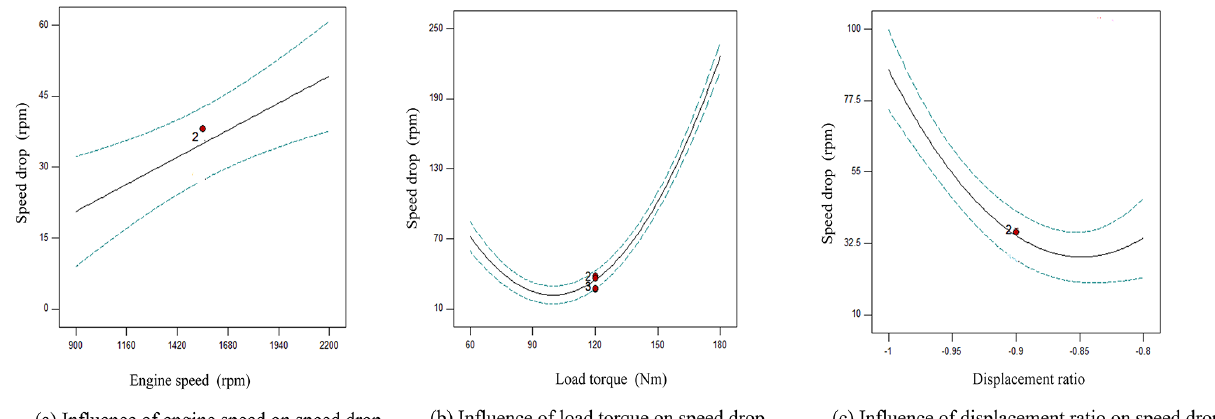
Figure 6. Single influencing factor analysis of speed